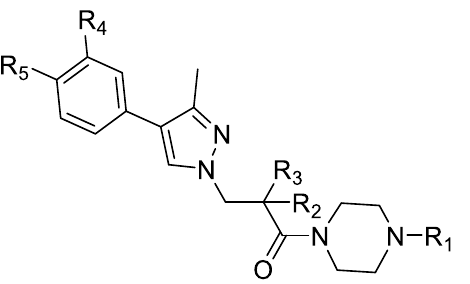
Figure 7. General formula of NNMT inhibitors described in Table 1 and Table 2. Table 1. Overview of NNMT inhibitors ( 1 )–( 13 ) and human/rat/mouse liver microsome (HLM/RLM/MLM) data Compound Number